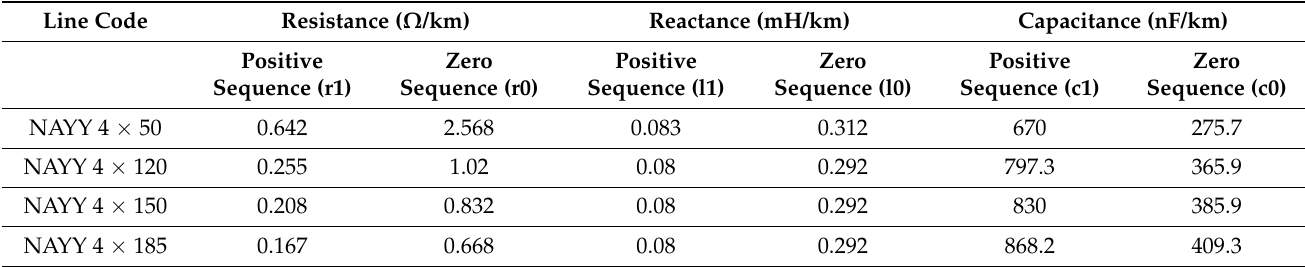
Table A1. Distribution line parameters with respect to line codes and specifications.